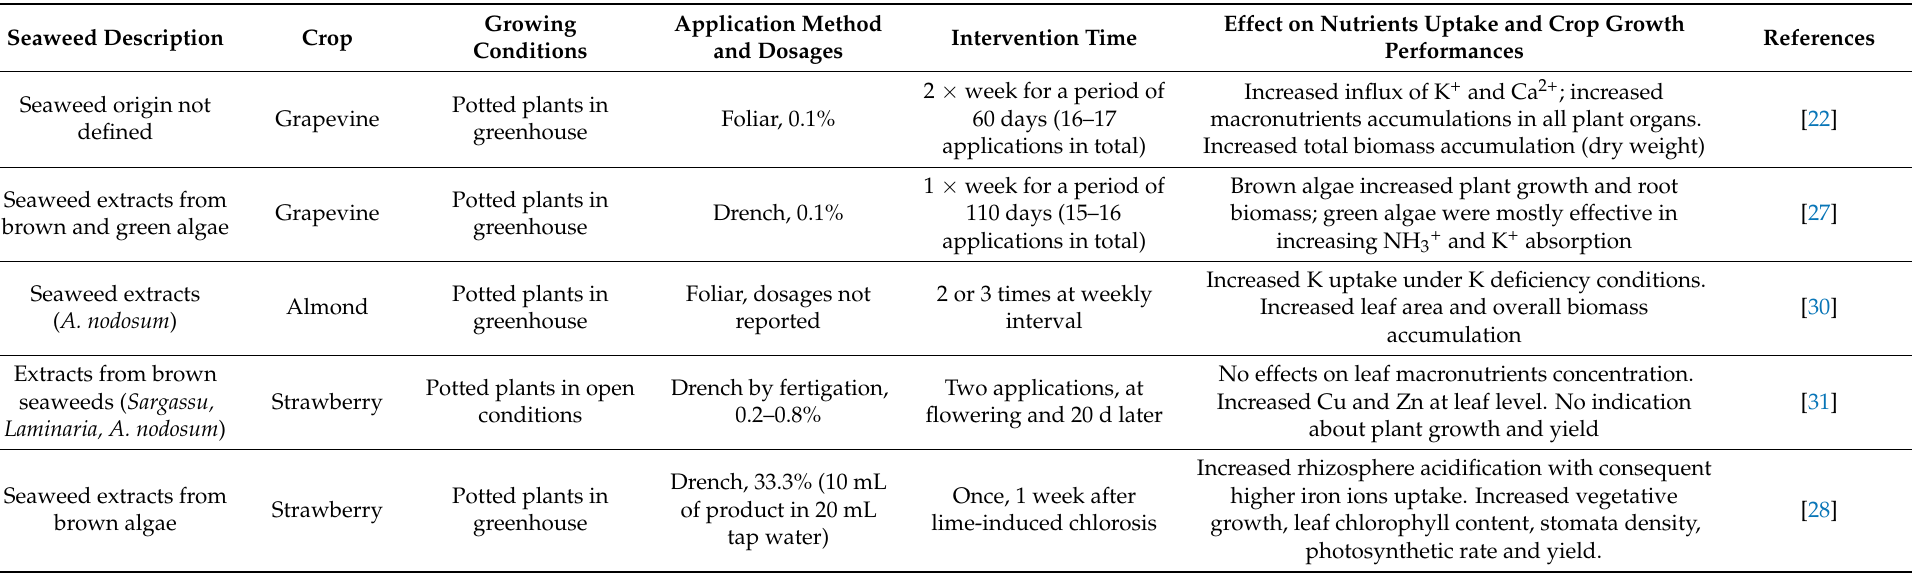
Table 2. Seaweed application methods to increase nutrient uptake and nutrient use